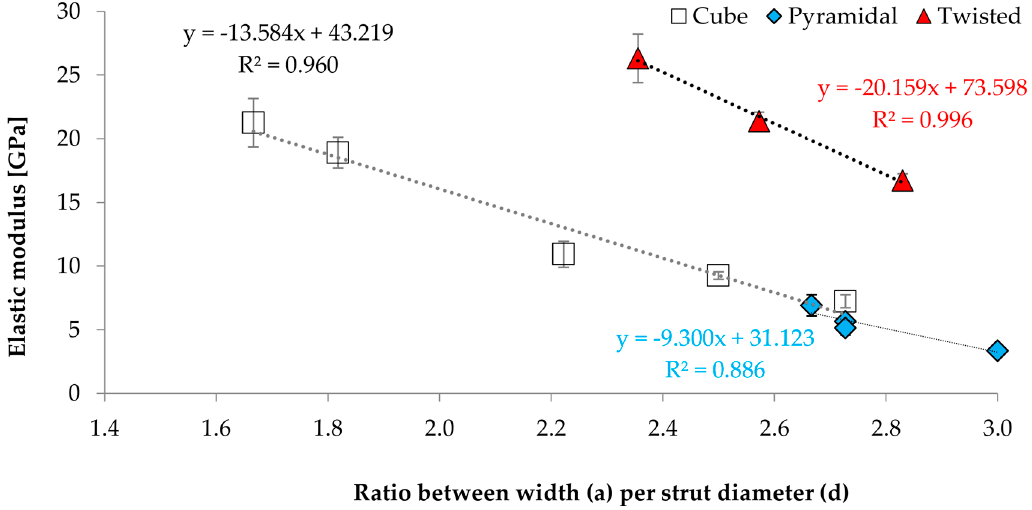
Figure 8. Correlation between the ratio a / d (width ( a ) and strut diameter ( d )) and elastic modulus in each of the investigated designs. Results are shown as mean values with the corresponding standard deviations. For the linear regressions, the coefficient of determination is shown.